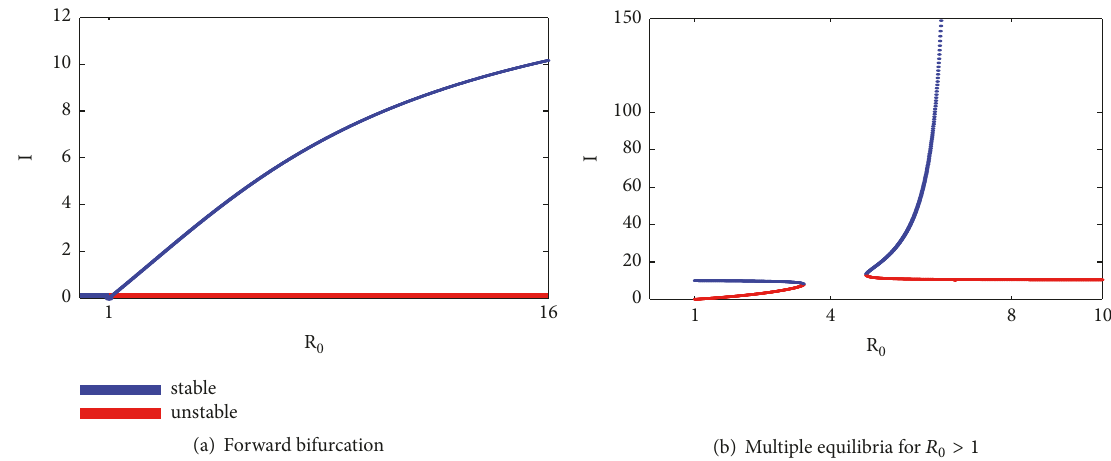
Figure 2: (a) Forward bifurcation graph for Λ = 0.5 , 𝛽 𝐵 = 0.4 , 𝐾 = 1 , 𝜇 = 0.2 , 𝜖 = 0.05 , 𝑑 = 0.1 , 𝛾 = 0.1 , 𝜎 = 3 , 𝛼 = 1 , and 𝛽 ℎ varies 𝛽 = 0.001 : 0.01 : 15. (b) Multiple equilibria for Λ = 2 , 𝛽 ℎ 𝛽 = 0 : 0.001 : 50. ℎ